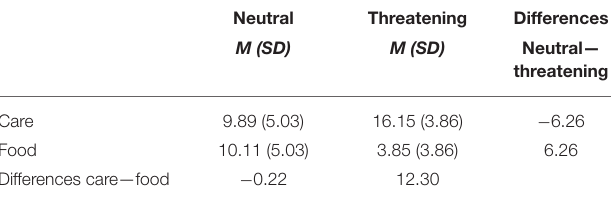
TABLE 2 | Means, SD, and differences between care and food choices in the two conditions.